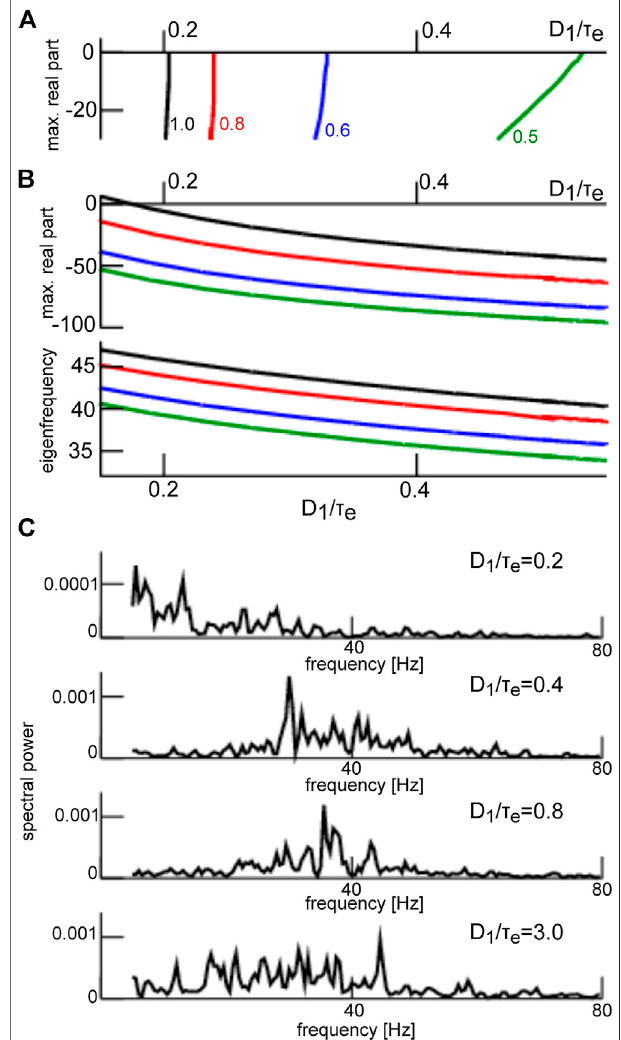
FIGURE 10 | Eigenvalues at the top and bottom branch in Figure 7 and corresponding power spectra. (A) maximum eigenvalue of equilibria on the top branch in Figure 7 . (B) maximum real part r of the eigenvalue r + i 2 π ] (top panel) and thecorrespondingeigenfrequencyfrequency ] .Thenumbers denotethevaluesofthestimulusratio q inallpanels. (C) Powerspectraof V ( t ) about the lower branch for q (cid:1) 0 . 6 for different noise intensities D 1 / τ e